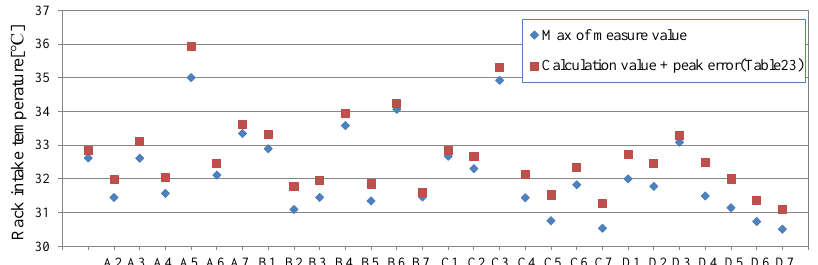
Figure 14. Relationship between calculation value + peak error and max of measure value for each rack. Table 21. Preliminary evaluation indices of rack intake temperature prediction model (8 November 2019 to 20 November 2019; sample number: 961).